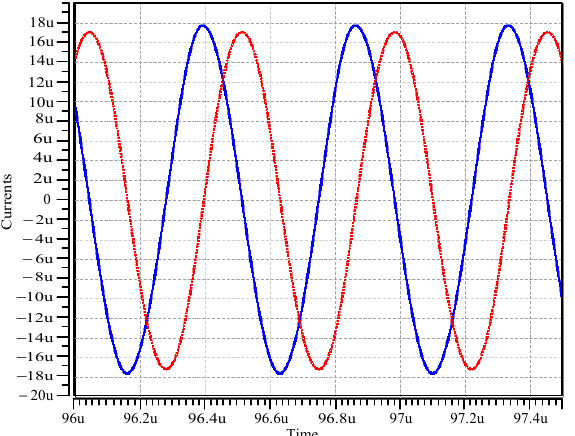
Figure 7. Simulated quadrature voltage outputs V o 1 (blue) and V o 2 (red).